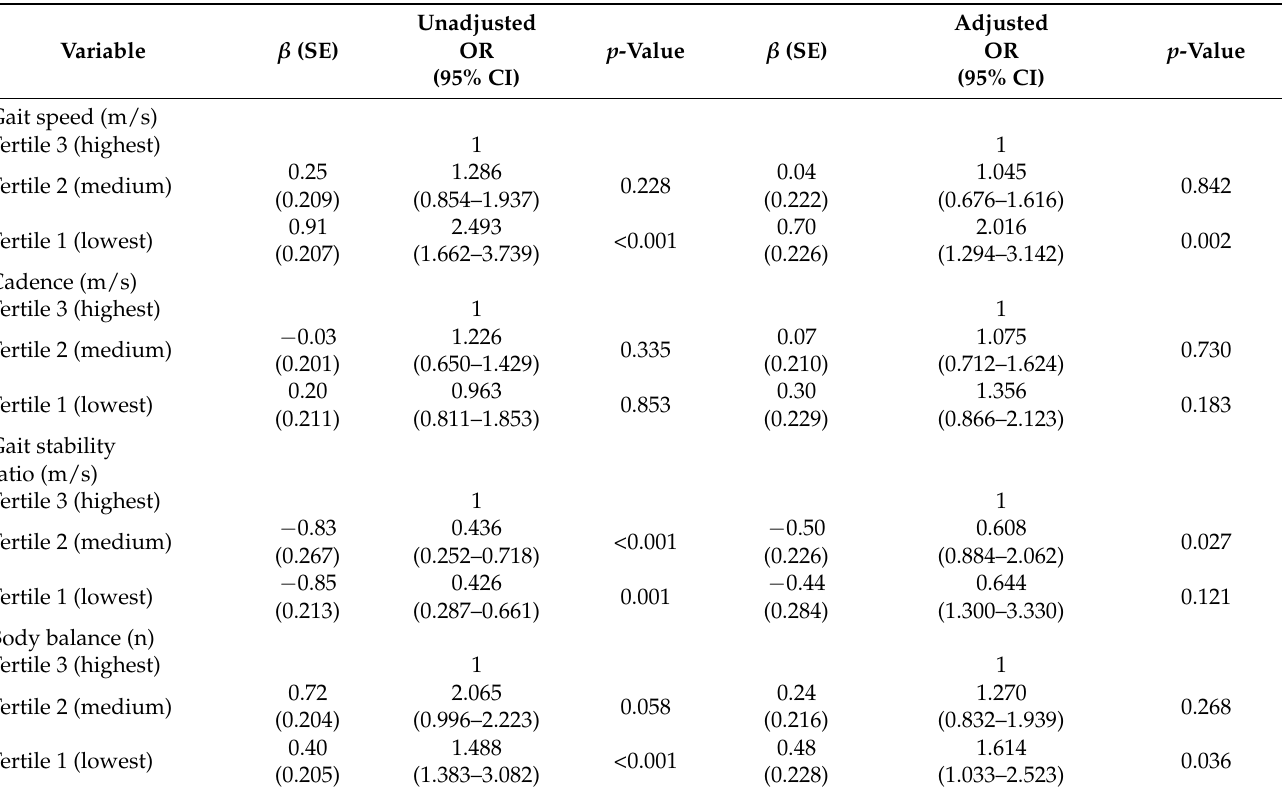
Table 4. Associations between gait speed, cadence, gait stability ratio, body balance versus falls, results expressed by multinomial logistic